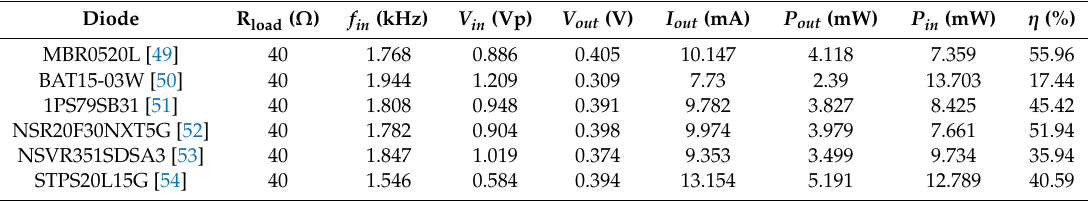
Table 17. Comparative results between di ff erent diodes at 3 m / s.